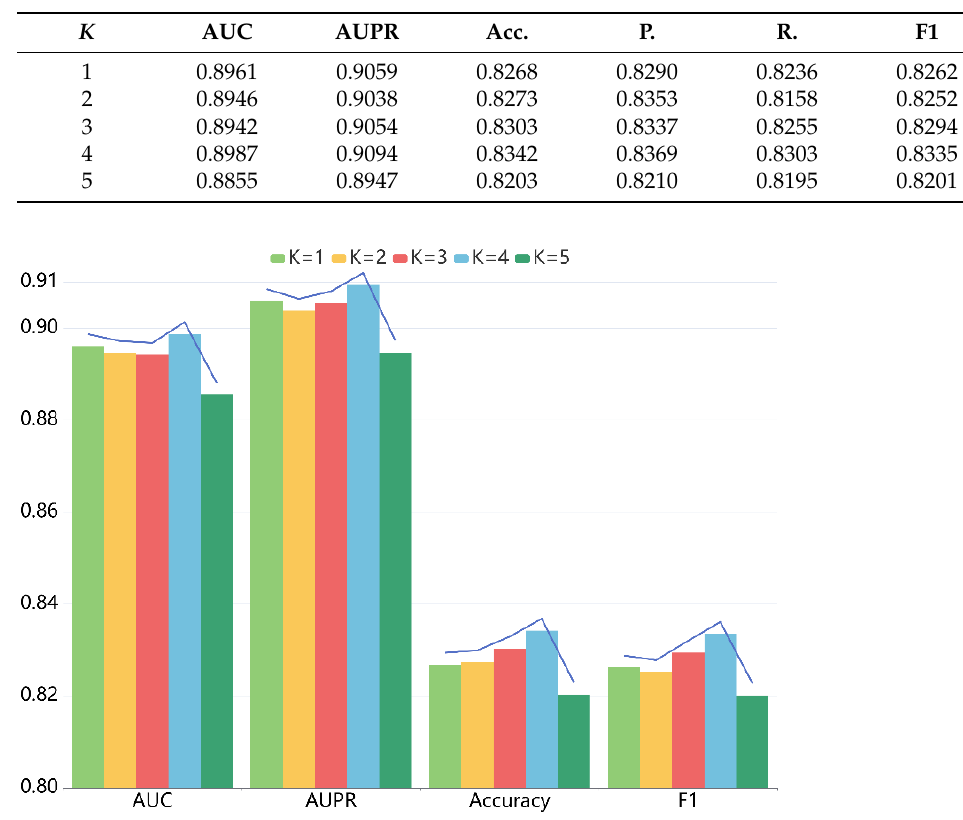
Figure 3. Effects of depth K on the performance of LRGCPND.